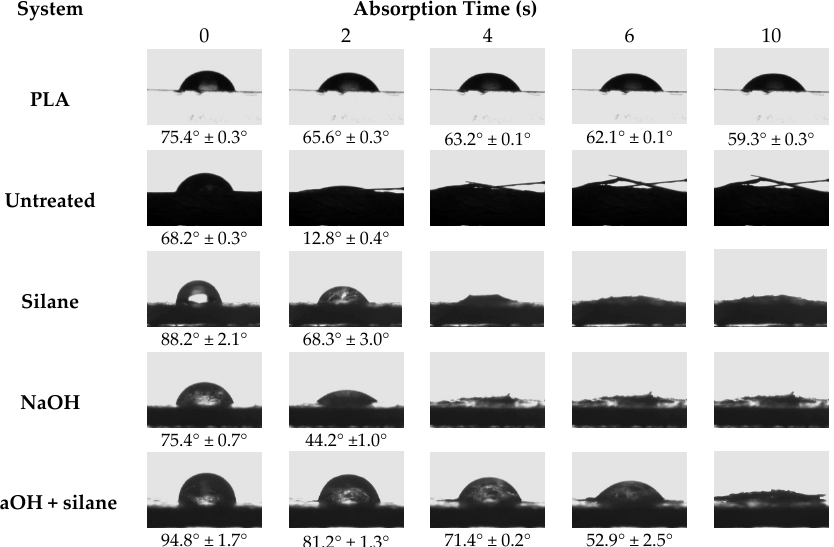
Figure 2. Contact angle values and the absorption of a water drop in neat poly(lactic acid) sample surface and in compressed disc geometry surfaces of sisal fibers at different intervals of time.